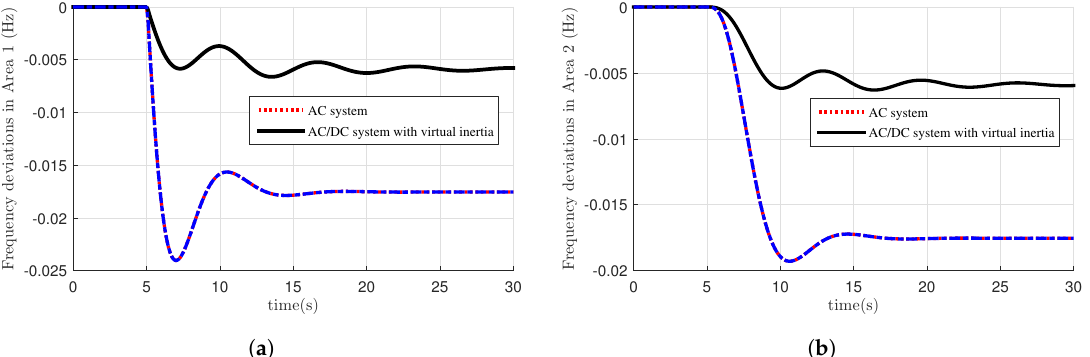
Figure 4. Case 1: results of both areas under a step-load change at 5s and also DoS attacks that start from 1s. ( a ) Frequency deviation of Area 1. ( b ) Frequency deviation of Area